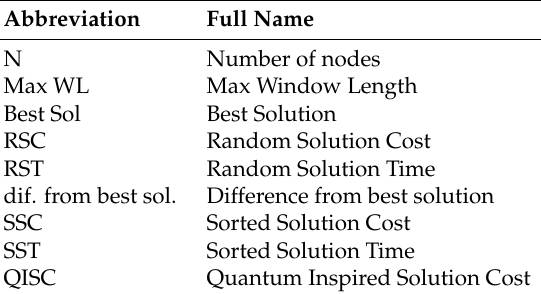
Table 3. Abbreviations [4] for the Table